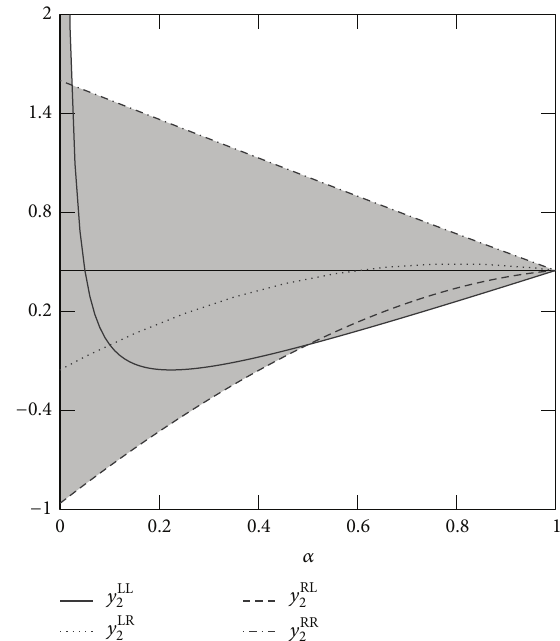
Figure 4: Solution candidates from Example